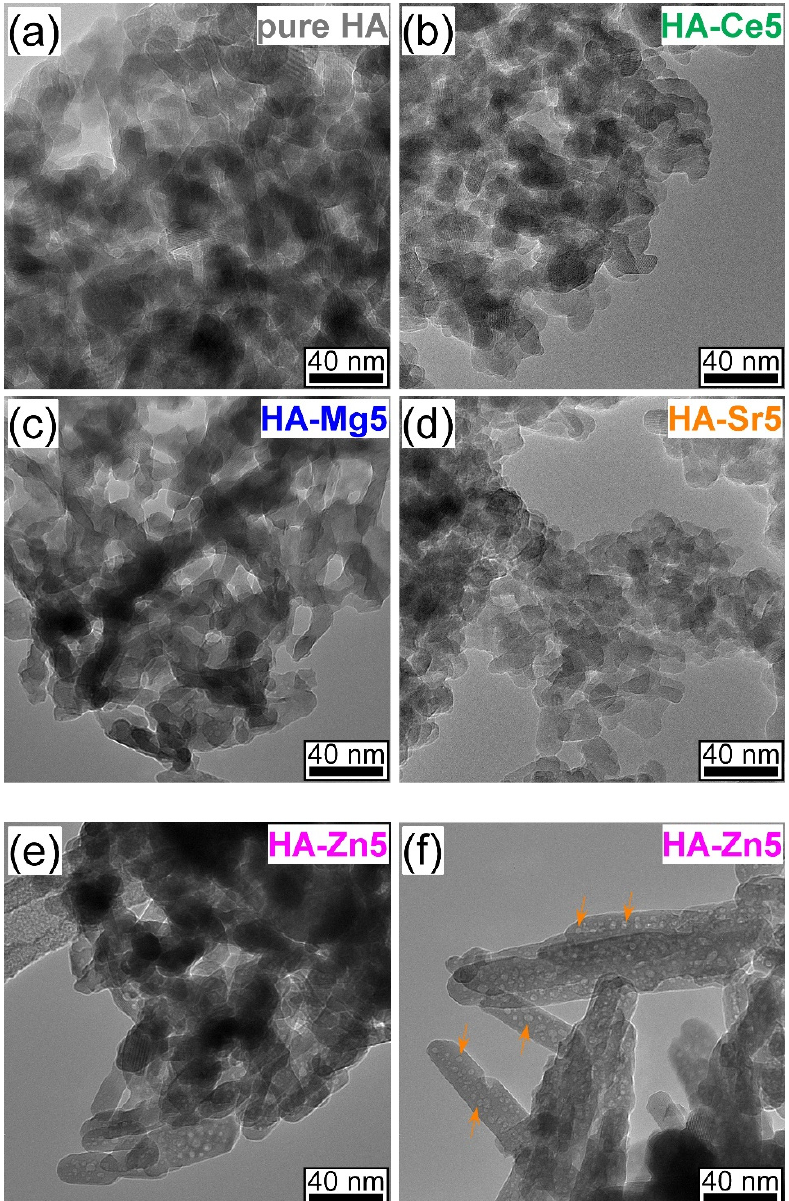
Figure 3. Characteristic comparative bright field transmission electron microscopy images of ( a ) pure HA and 5 at.% ( b ) Ce, ( c ) Mg, ( d ) Sr, and ( e , f ) Zn-substituted HA.